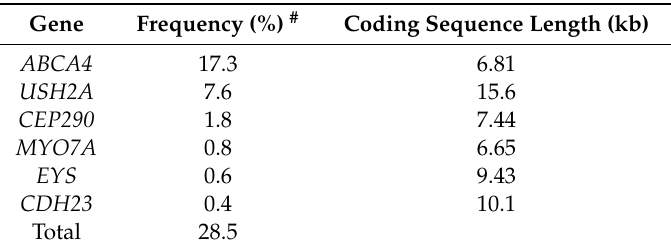
Table 2. Six most commonly implicated genes in recessive inherited retinal degeneration with coding sequences greater than the packaging capacity for a single AAV. # Analysis of data from Stone et al. [6] on cases in the USA.